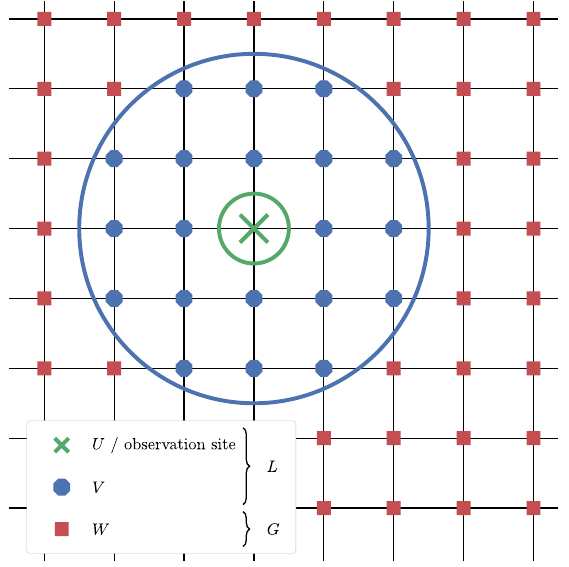
Figure 19. Example of the UV W partition for a two-dimensional space. The site of observation y q lies in the middle. The local re- gions U and V are circumscribed by the thick green and blue circles and contain 1 and 20 grid points, respectively. The global region W contains all remaining grid points. In the case of the LG partition, the local region L gathers all 21 grid points in U and V